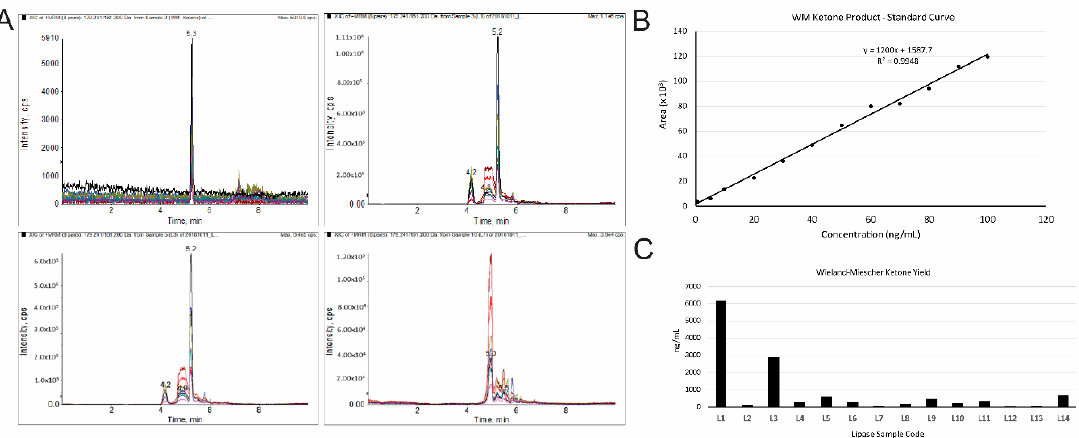
Figure 2. Development of an LC/MS method for biocatalyst screening. ( A ) LC/MS data for standard (upper left) and lipases L1, L3, and L7 (clockwise from upper right). ( B ) Standard curve for Robinson annulation product ( 3 and 4 ) generated with LC/MS method. ( C ) Quantification of data for lipase library using standard curve from ( B ). Reaction conditions: The following reagents/reactants were mixed in a centrifuge tube for synthesis of Wieland–Miescher ketone: methanol (1 mL), methyl vinyl ketone (81 µL), 2-methyl-1,3-cyclohexanedione (23 mg), deionized water (100 µL), and lipase (5 mg). After reactant assembly, centrifuge tubes were placed in a shaker (30 °C, 250 rpm) for 48 h. Target mass (m/z) = 178.10.